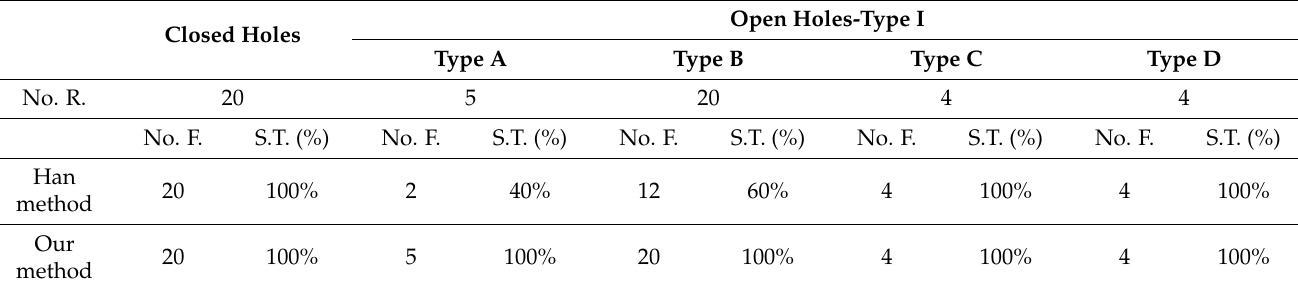
Table 3. Distribution and repair statistics of closed holes and type I open holes.